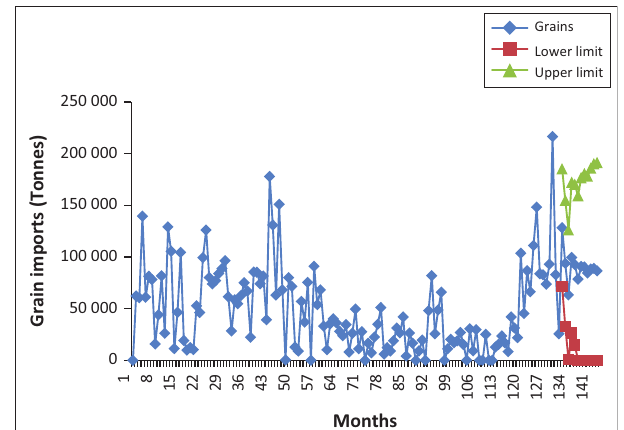
FIGURE 9: Adjusted forecast of grain imports through the bulk grain terminal in the Port of Cape